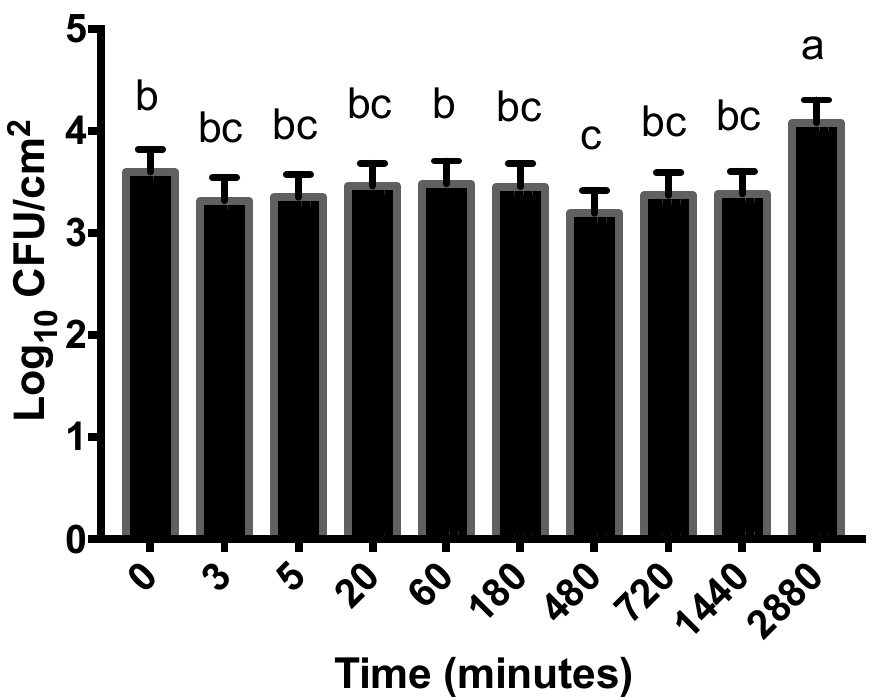
Figure 2. Populations of Shiga toxin-producing Escherichia coli (STEC) cells grown in M9 minimal nutrient media attached to lean and adipose beef brisket tissues at each sampling time point. The main effect of time was significant ( p < 0.0001). As all variable interactions were not significant ( p > 0.05), all data for each time point are combined into a single observation. a,b,c Observations with different superscripts vary statistically.